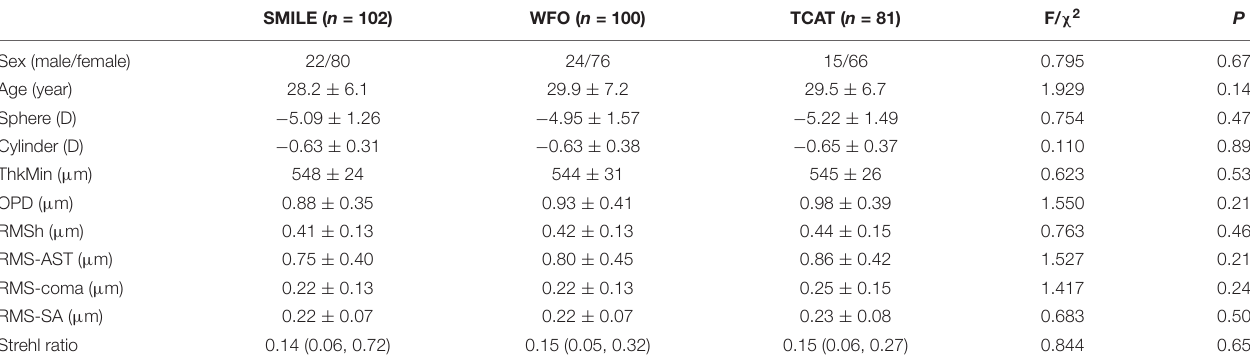
TABLE 1 | Baseline clinical data and demographics in the three groups.